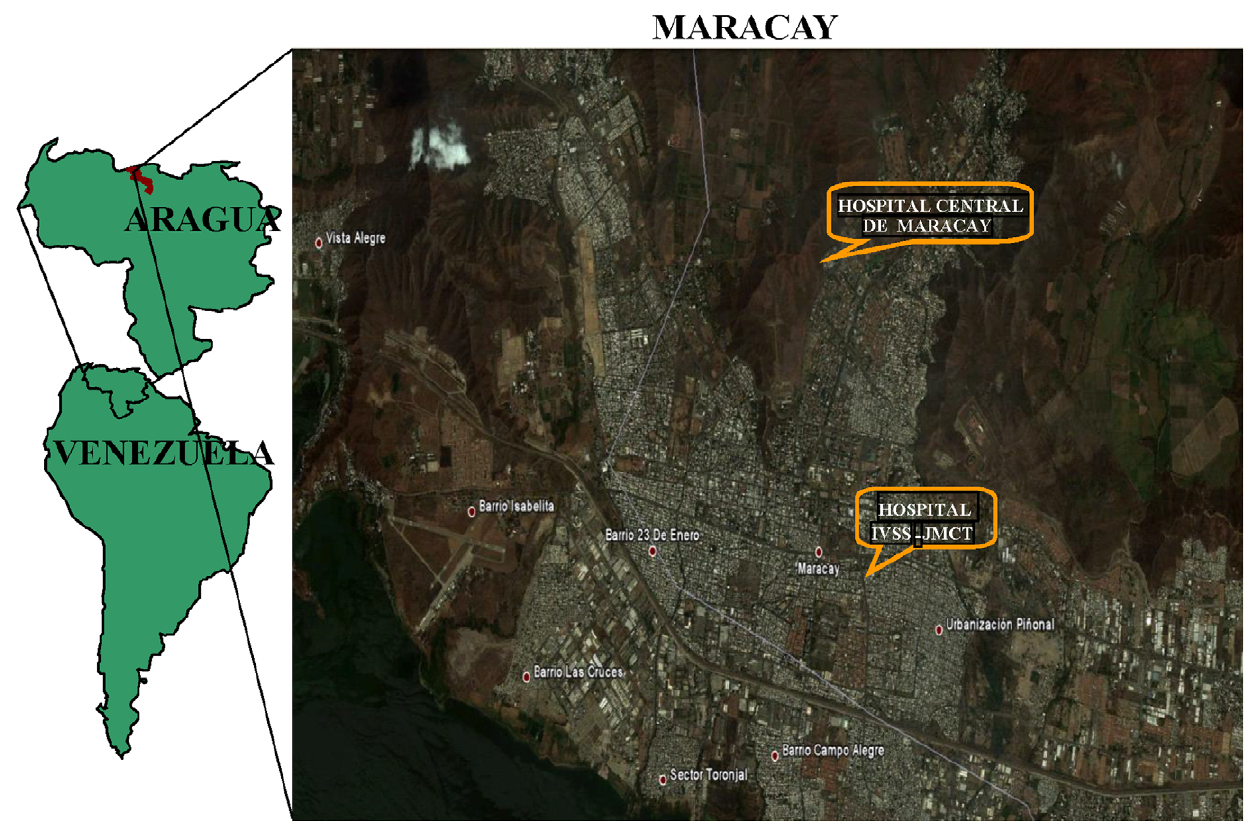
Figure 4. Map of study sites in Venezuela.